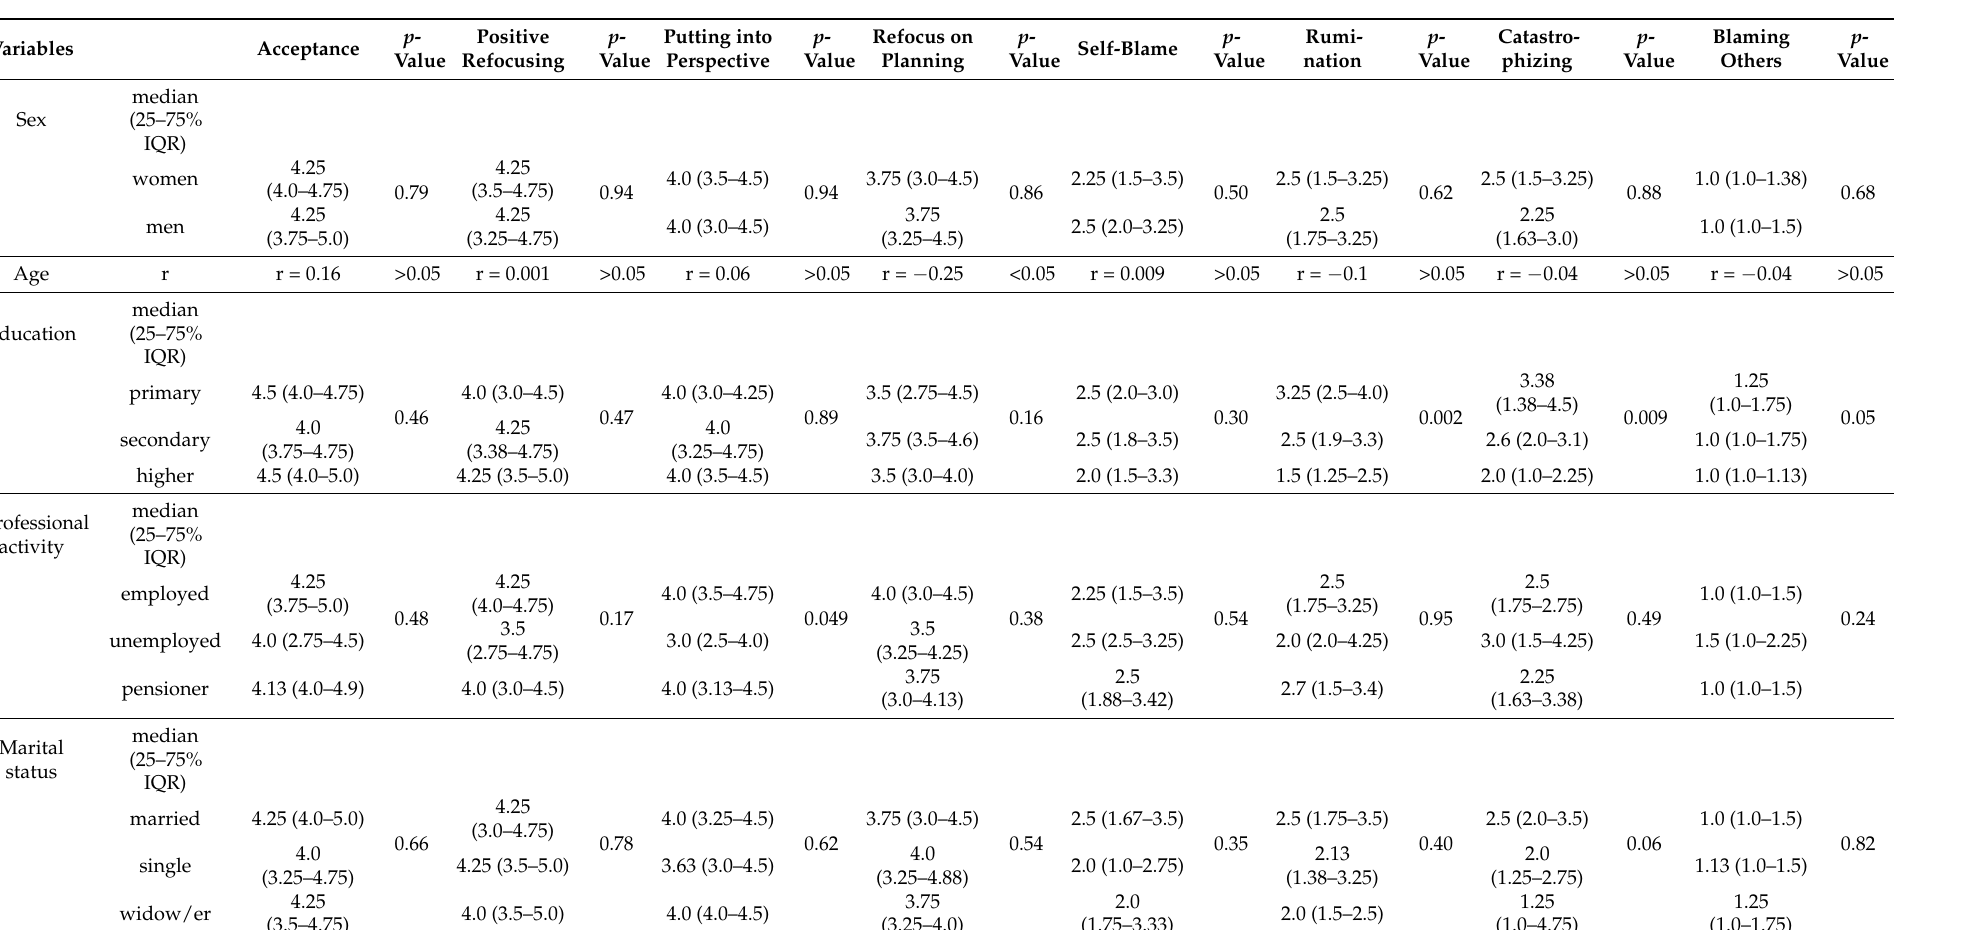
Table 2. Cognitive strategies among cancer patients due to various